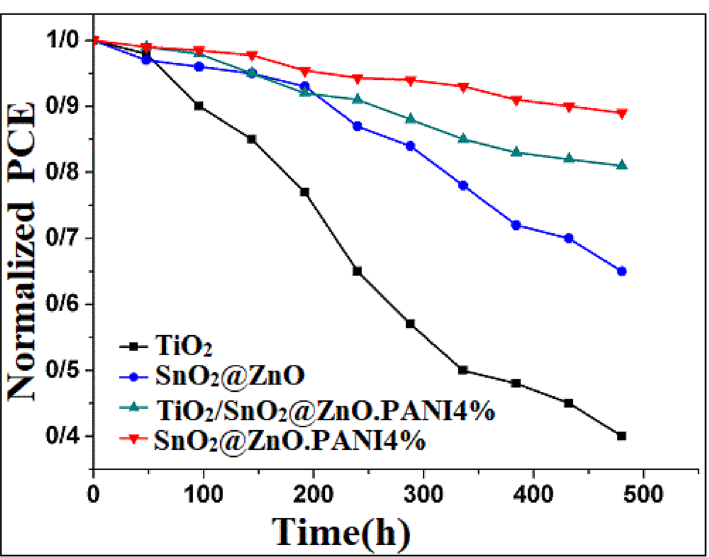
Figure 16. Stability test of perovskite solar cells for 480 h (All devices are placed in ambient